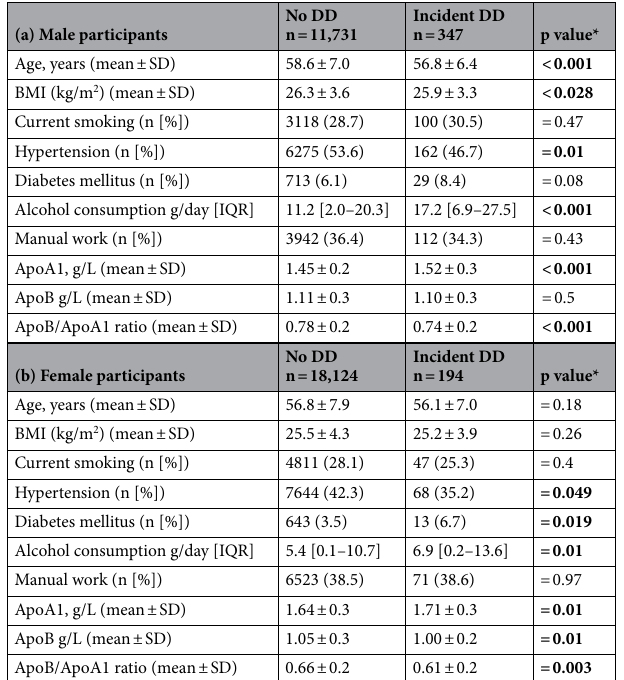
Table 2. a, b Baseline characteristics with all subjects, stratified with regard to incident DD . Participants with prevalent DD at baseline (n = 50) were excluded. *P-value for group comparison between subjects without DD and with incident DD; independent sample t-test used for age, BMI and lipid levels, Chi-Square test for dichotomous variables and Mann–Whitney U test was used for alcohol consumption. Participants with prevalent DD are excluded. Bold values indicating p < 0.05. APO Apolipoprotein, BMI body mass index, DD Dupuytren’s disease, IQR interquartile range, SD standard